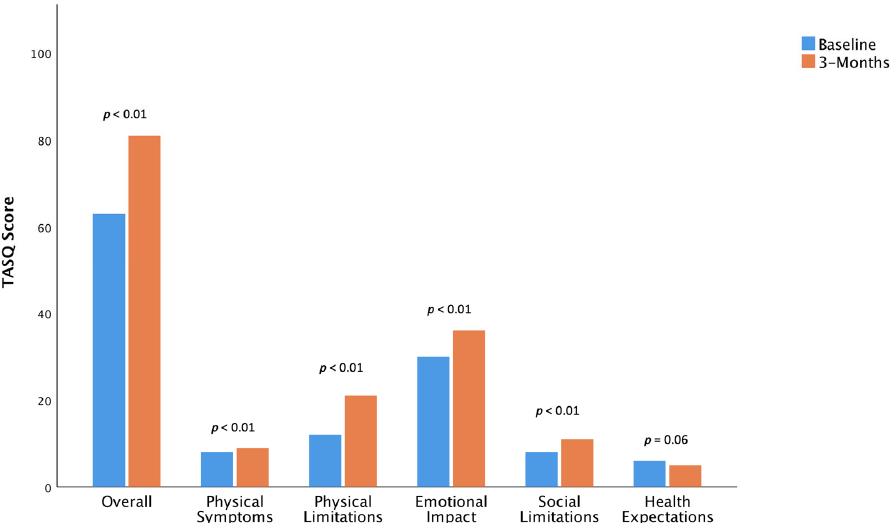
Figure 1. Absolute modification of TASQ score in sarcopenic patients at 3-month follow-up compared with baseline.